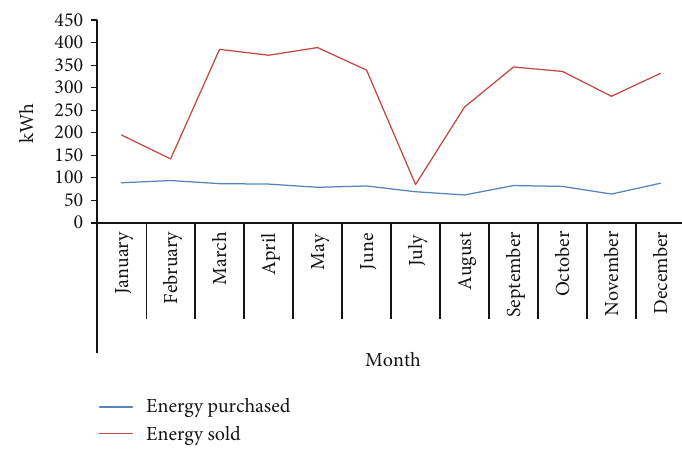
Figure 25: Grid sales against grid purchases of the unreliable grid with the PV system model